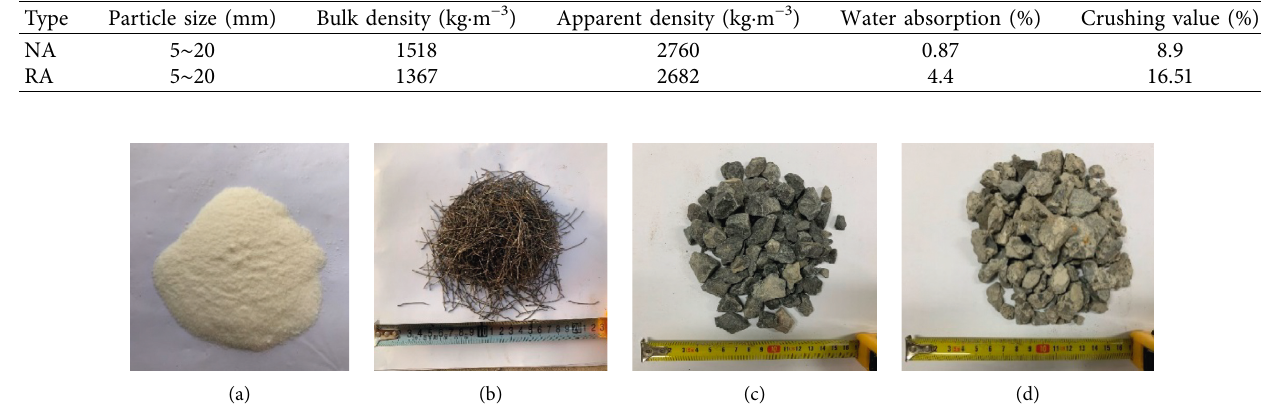
Table 3: Physical properties of coarse aggregates.